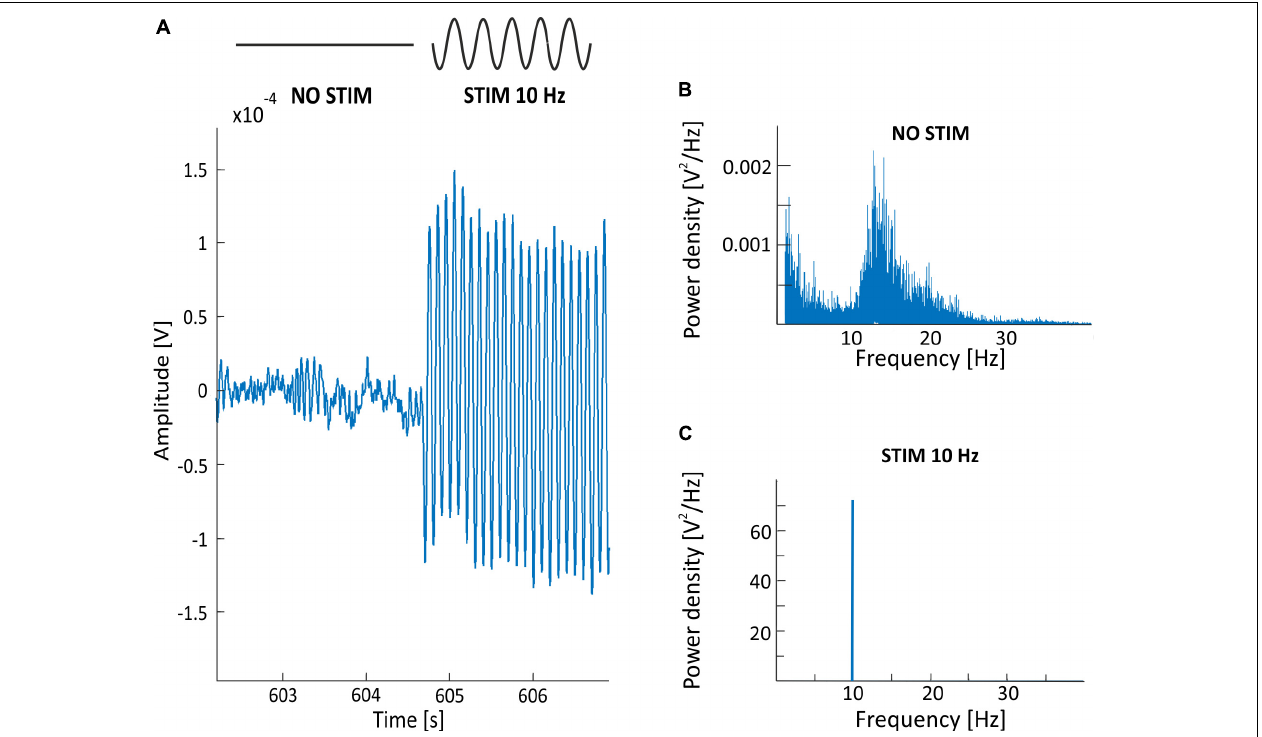
FIGURE 1 | (A) Example of the EEG recording (electrode O2; one exemplar participant) with a visible stimulation artifact starting around 604.5 s and resulting from an applied 40 µ A 10 Hz sinusoidal to ACS. The EEG signal with superimposed stimulation artifact is 10 times greater in amplitude than the EEG signal recorded prior to stimulation. (B) Power spectrum density (PSD) before stimulation in a condition with an excitation in alpha band (i.e., closed eyes). The large intensity of artifact in 10 Hz during stimulation (C) doesn’t allow for the analysis of the spectrum of endogenous brain activity in alpha band. PSD obtained from 5 min of signals, recorded at a 500 Hz sampling